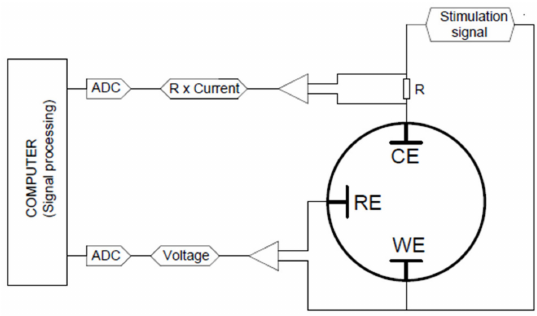
Figure 4. Simplified diagram of the voltage transient (VT) measurement setup used in our lab. WE, RE, and CE represent the working, reference, and counter electrodes,